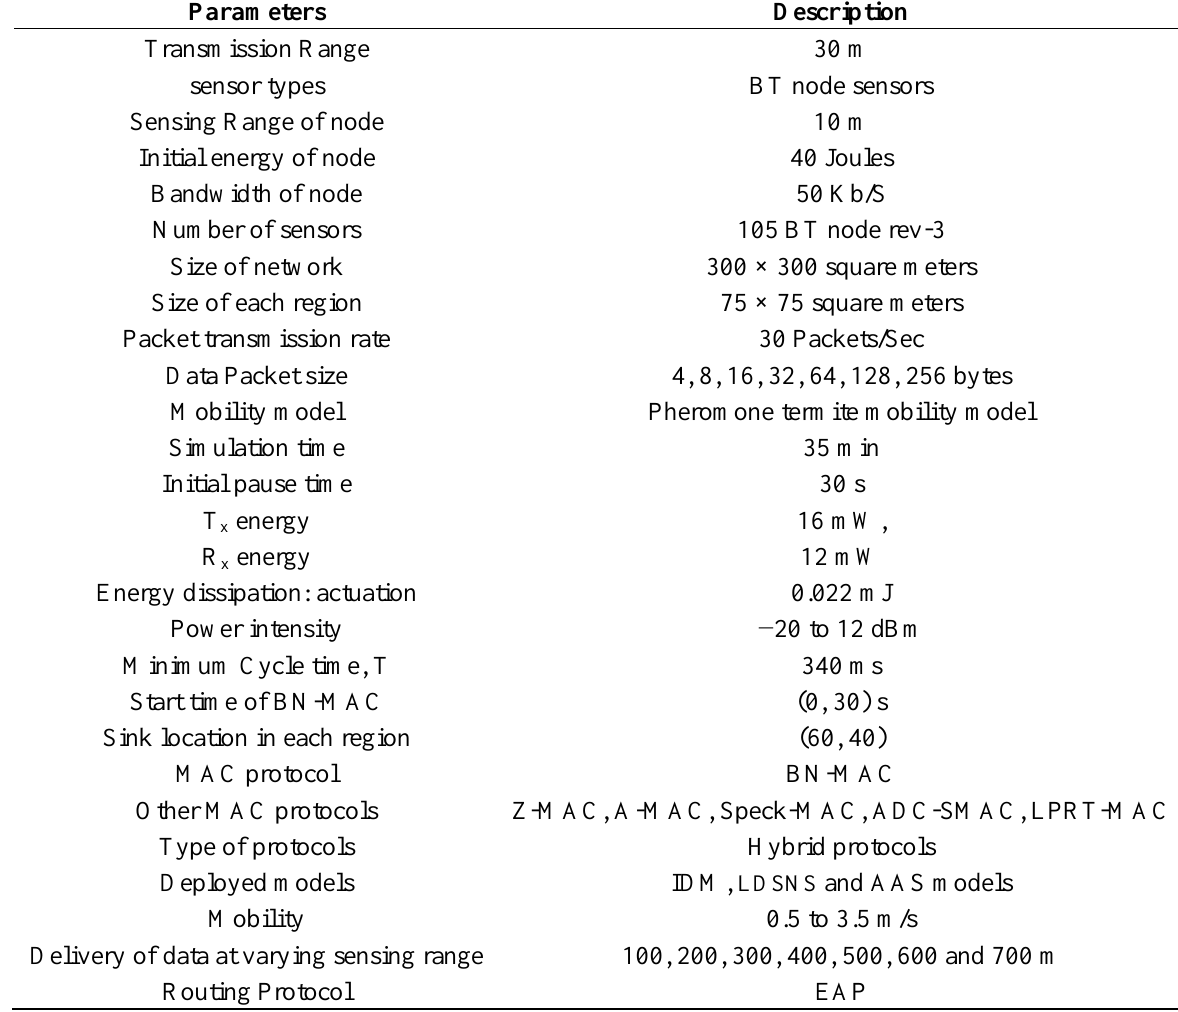
Table 2. Parameter values used in the simulation